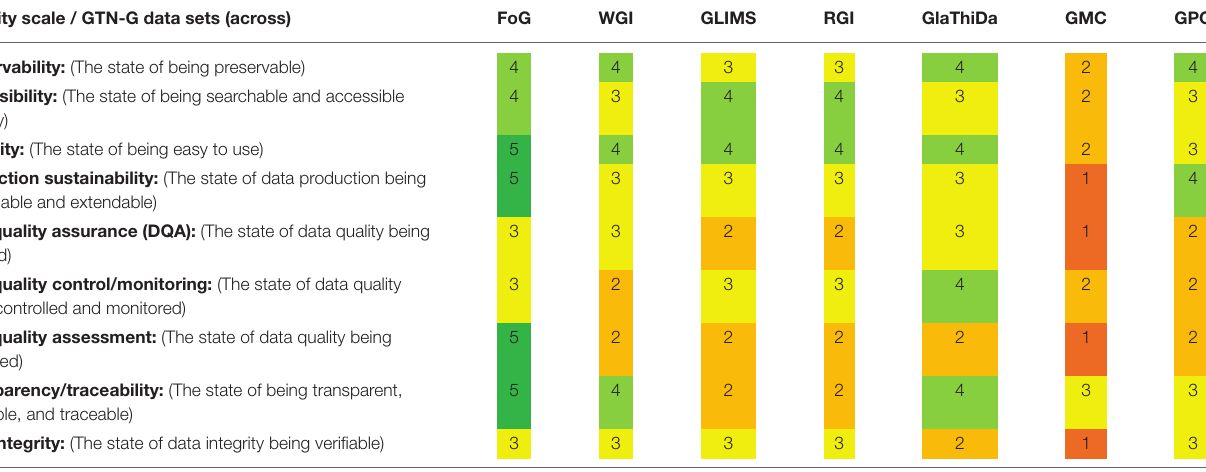
TABLE 3 | List of all GTN-G datasets with their URL (Uniform Resource Locator) and citation. Dataset URL Citation Fluctuations of Glaciers (FoG)